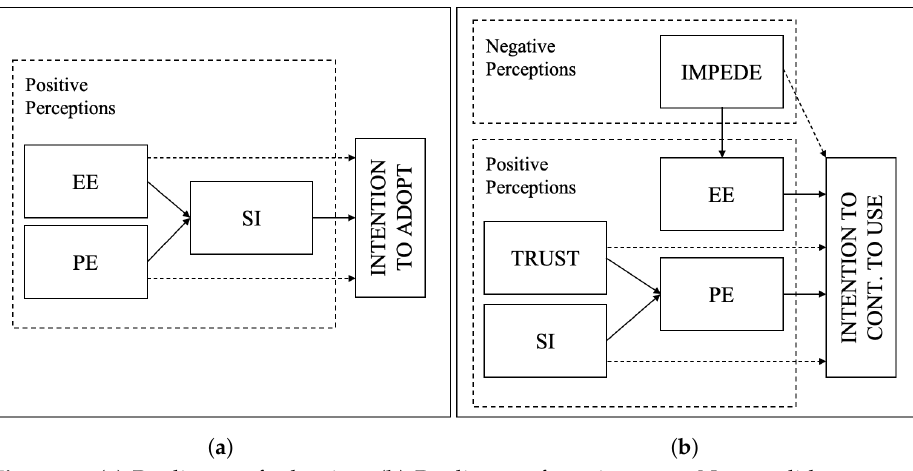
Figure 2. ( a ) Predictors of adoption, ( b ) Predictors of continuance. Note: solid arrow = direct relationship; dotted arrow = indirect